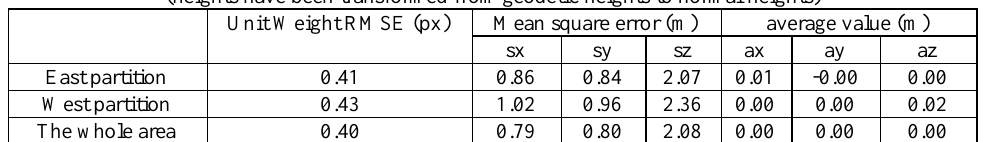
Table 5: Adjustment accuracy comparison of the east, west and whole teat areas with horizontal and vertical geometric constraints